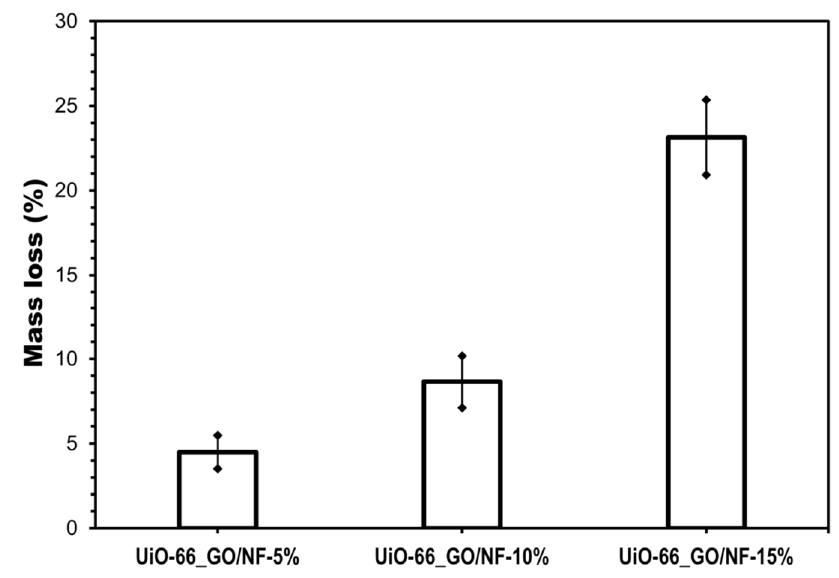
Figure 6. Mass loss (%) of UiO-66_GO nanocomposites after five washes.